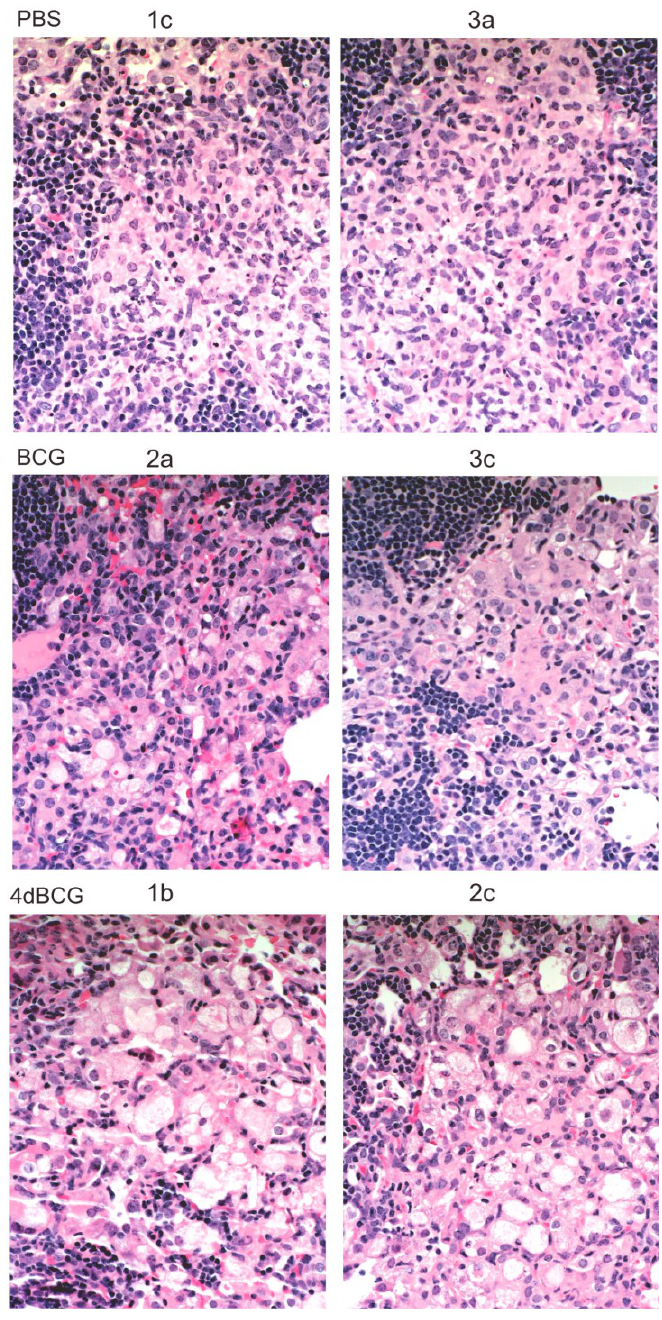
Figure 6. High-power views of lymphohistiocytic nodules. Consolidated lung tissue with many epithelioid cells containing pale oval nuclei and eosinophilic cytoplasm are observed in the PBS-vaccinated mice and to a lesser degree in the BCG-vaccinated mice. The alveolar spaces adjacent to the smaller lymphoid nodules in the 4dBCG-vaccinated mice are edematous, contain relatively fewer epithelioid cells, and exhibit greater preservation of alveolar wall architecture than in the PBS- and BCG-vaccinated